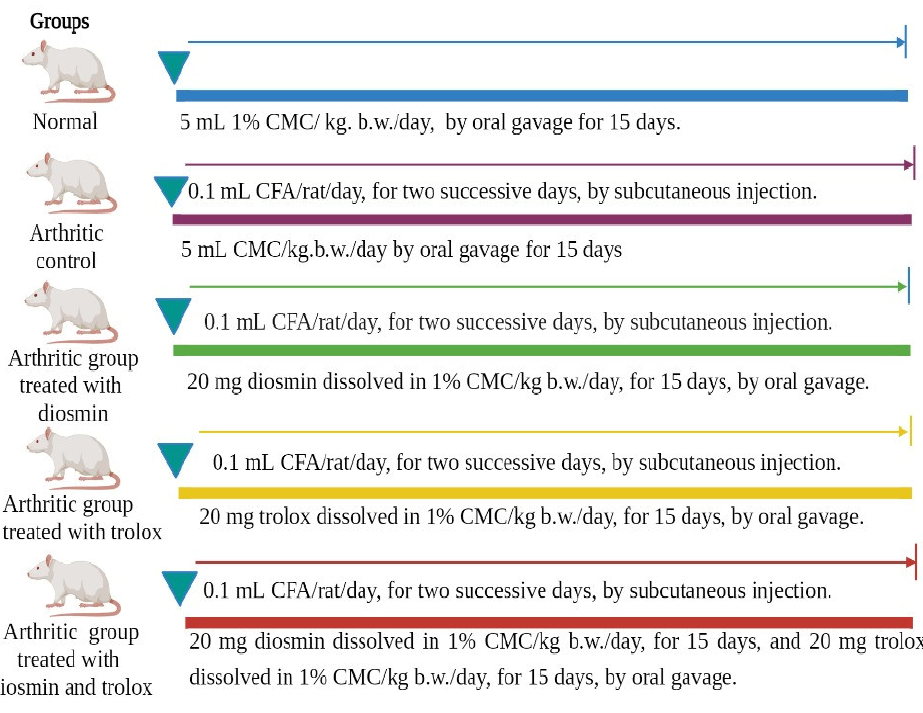
Figure 1. Experimental design and animal grouping.